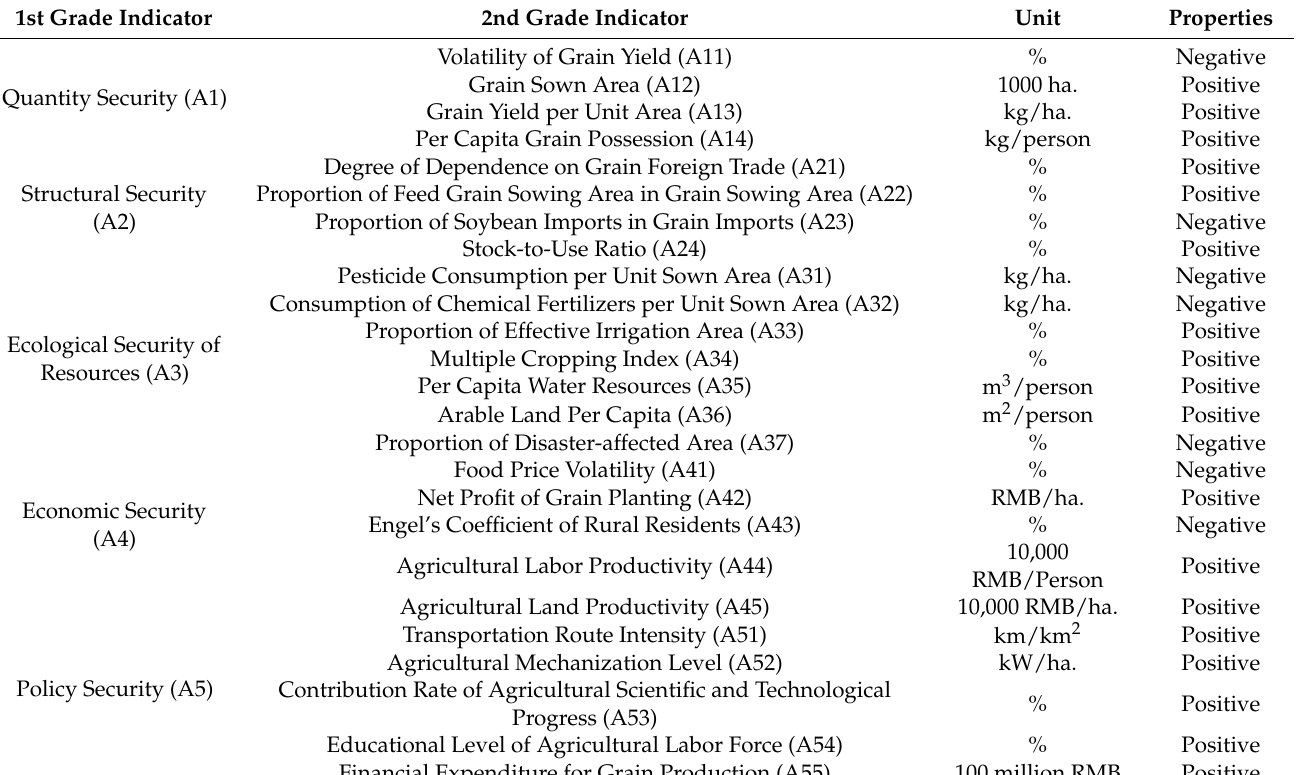
Table 1. Food Security Evaluation Indicator